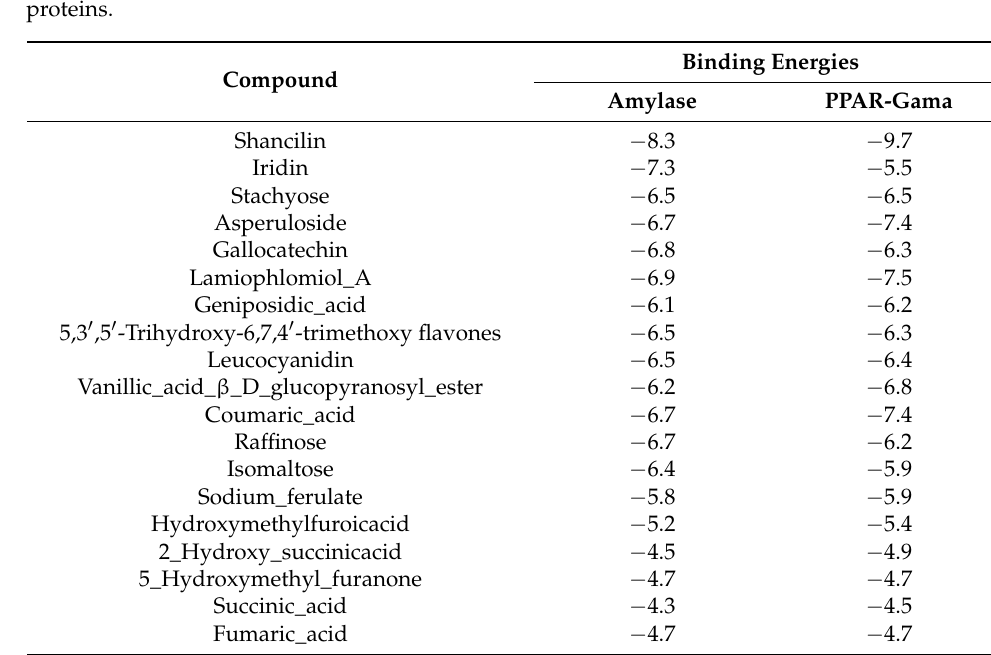
Figure 1. LC-MS chromatogram of BGH sample spectral data is listed in Table 1. The x -axis shows retention time in minutes; the y -axis shows the intensity.